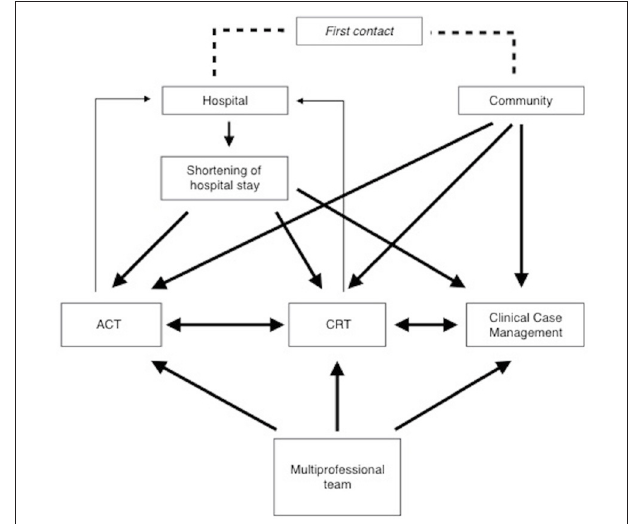
FIGURE 1 | Description of the model project of need-adapted care. ACT, Treatment modus comparable to Assertive Community Treatment; CRT, Treatment modus comparable to Crisis Resolution